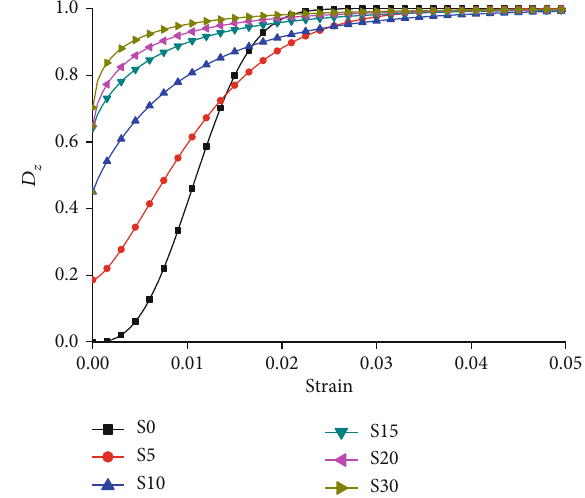
Figure 10: Evolution curve of load damage under sandstone cyclic